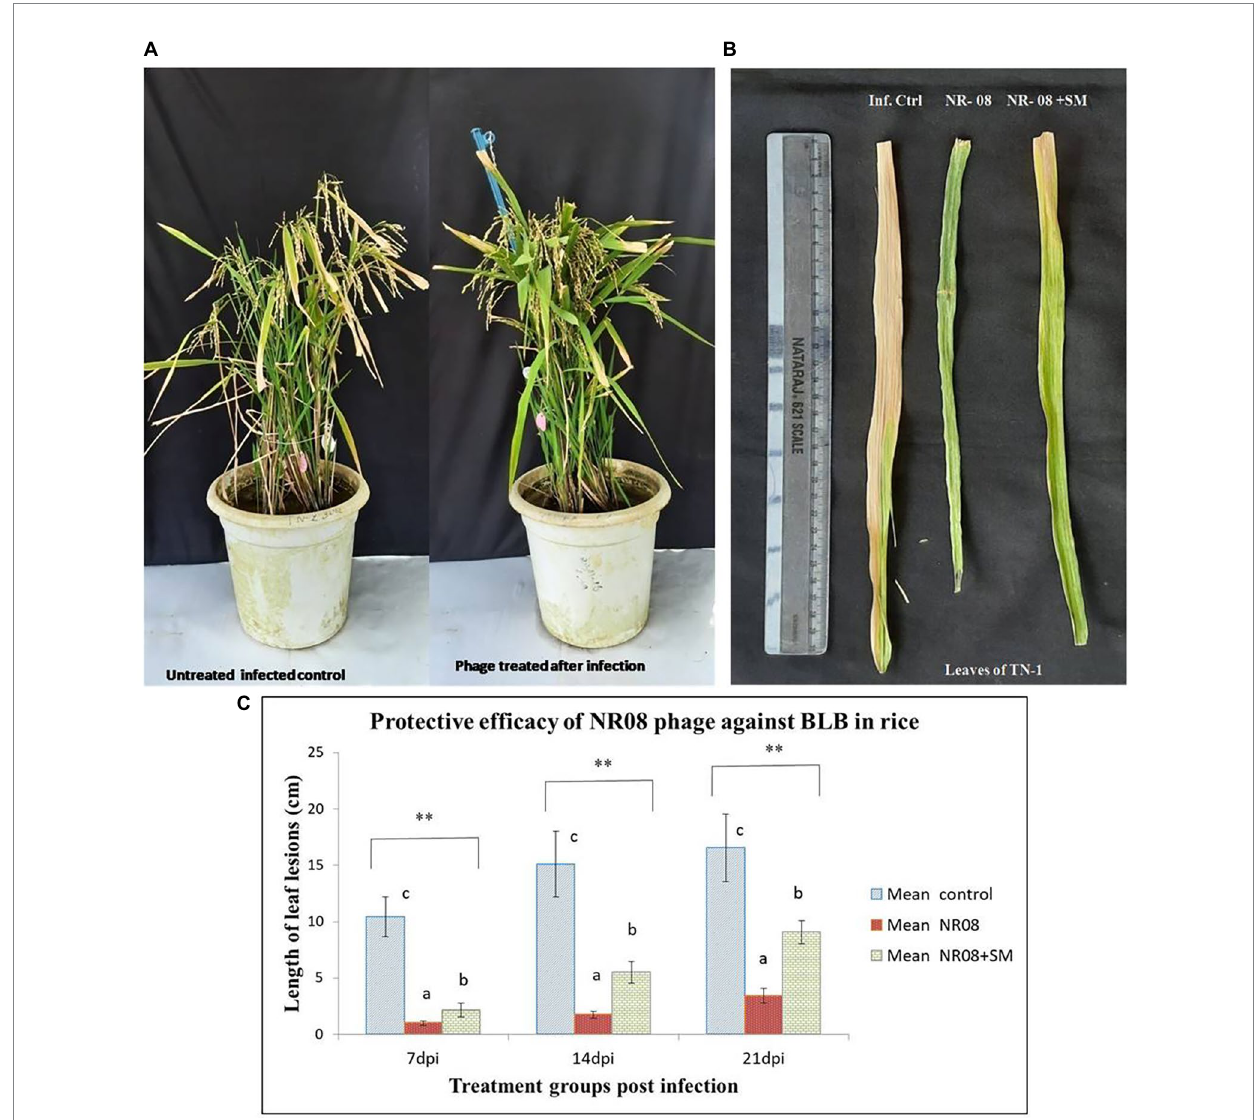
FIGURE 10 Protective efficacy of phage in rice pot against BB in rice. (A) Phage-treated TN-1 rice plants showing significant reduction of BLB symptoms as compared to untreated control plants after 14 days of infection and 11 days of phage treatment; (B) leaves of rice plants highly susceptible TN-1 variety after 15 days of infection with XooCG01 by leaf clip method and 11 days of phage treatment with NR08 phage in two preparations: neat phage (NR08); phage with 2% skim milk (NR08 + SM) by spray method. Infected control plants were infected with XooCG01 by leaf clip method and sprayed with sterile water only on the day of phage treatment; (C) Protective efficacy of NR08 phage-treated plants and NR08 along with 2% skim milk (SM) treated plants in comparison with untreated infected control plants of rice for bacterial blight symptoms in terms of length of leaf lesions (cm) at 7, 14, and 21 dpi. ** indicates a significant difference between all the three groups p < 0.01 at different points in